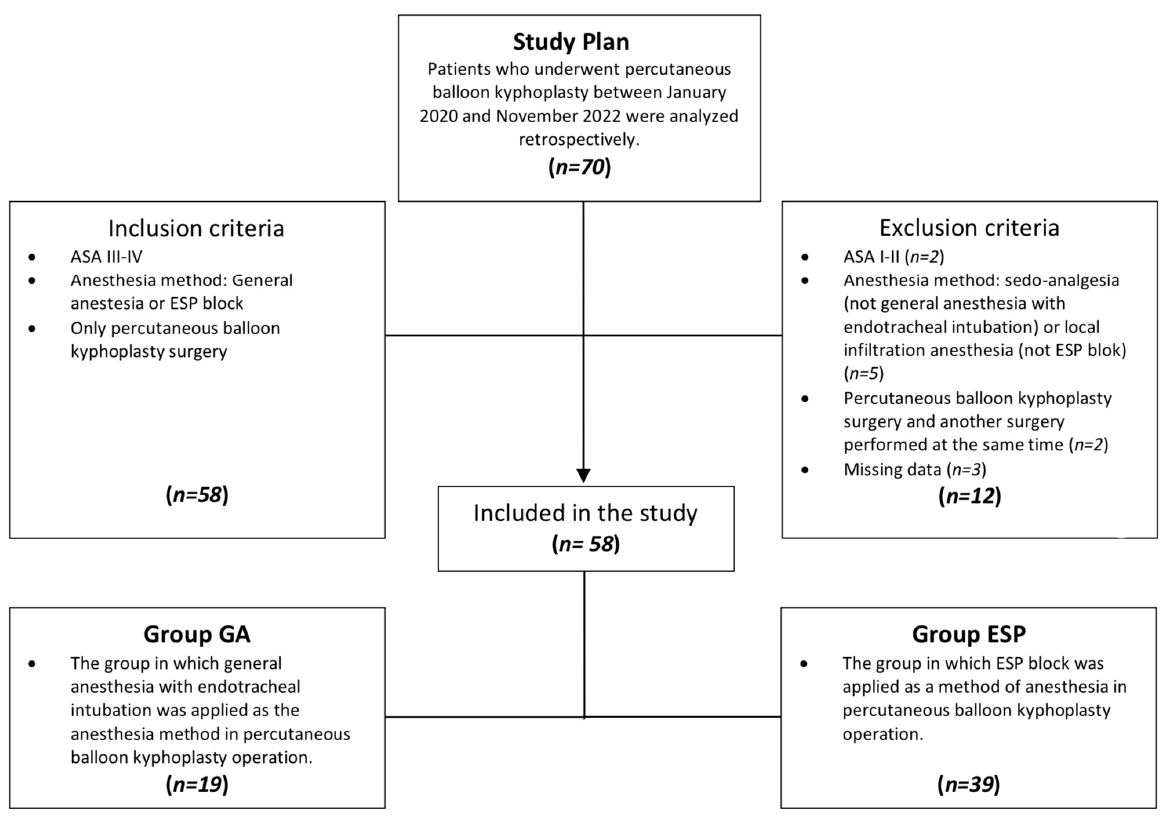
Figure 1. Flowchart of the current study.